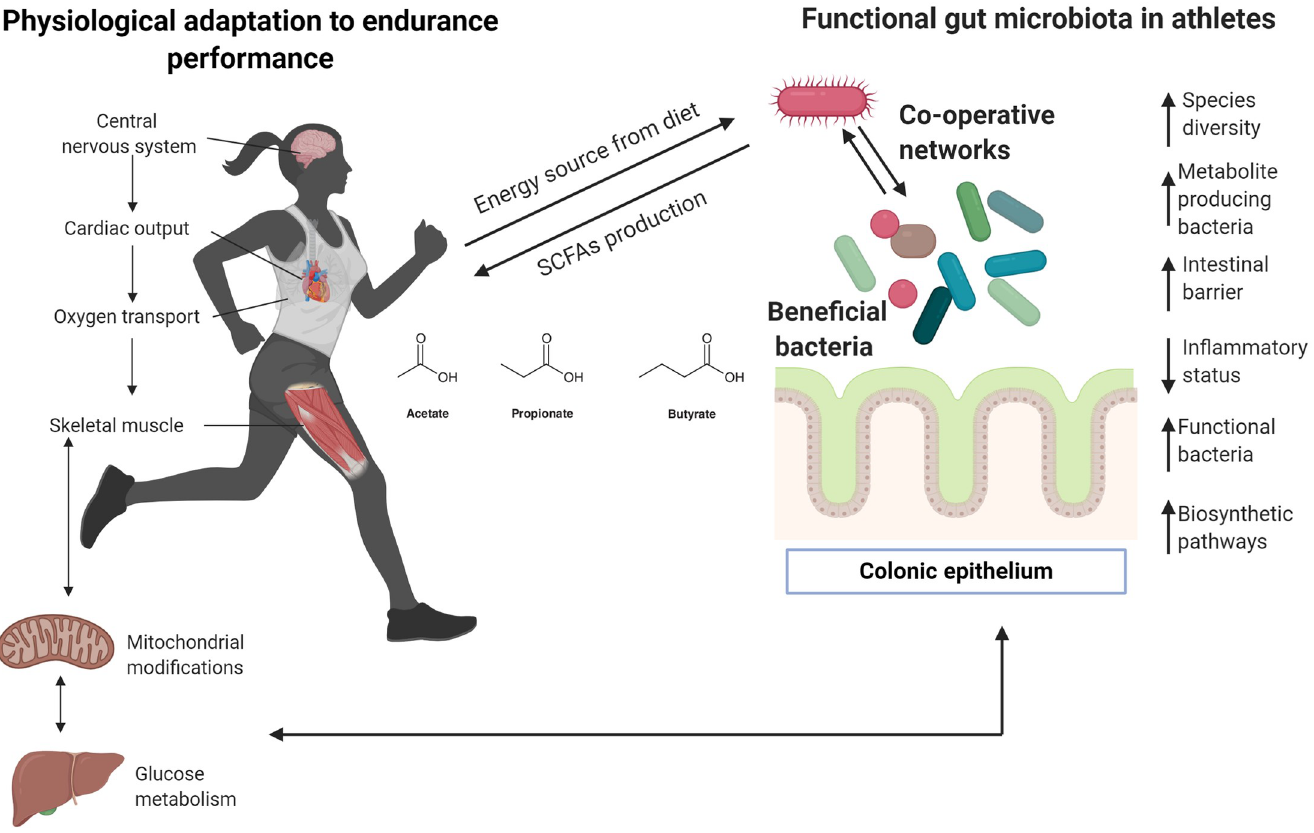
Fig 3. Insights about meta-community adaptation among gut microbiota in athletes. Most human physiological systems adapt to performance endurance, especially in elite and competitive athletes. Clear differences between physically inactive and athletic individuals have been described previously, particularly regarding cardiorespiratory adaptation given that endurance activities require major oxygen capacity to transport oxygen to different organs, including muscles and the liver. Efficient glucose and fatty acids metabolism are required to provide substrates that are finally transformed into energy by mitochondria. Recent research indicates that unique gut microbiota may be present in elite sportspeople, and special and unique bacteria can positively impact the host, providing substrates from the diet. Here, it is proposed that modifications of the gut microbiota ecosystem need to create co-operative networks to improve metabolic functions, particularly the production of biometabolites that can be used for the host (in this case, during highly demanding performance activities). Arrows denote an increase ( " ) or decrease ( # ). Figure created with